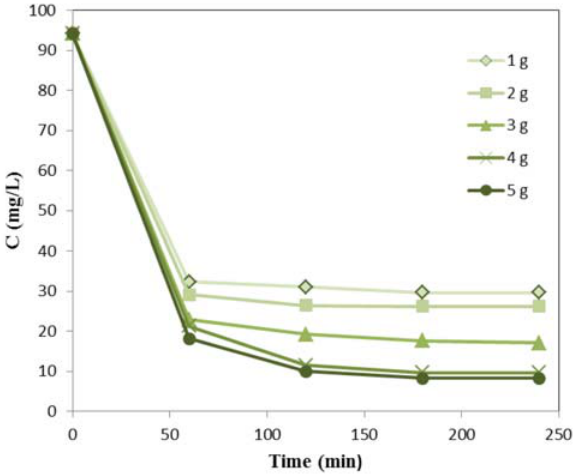
Figure 2. Influence of the WGT quantity (untreated) over the evo- lution of concentration in time (296 K, 94 mg/L, 100 mL, 200–400 μm, 300 rpm, 240 min).